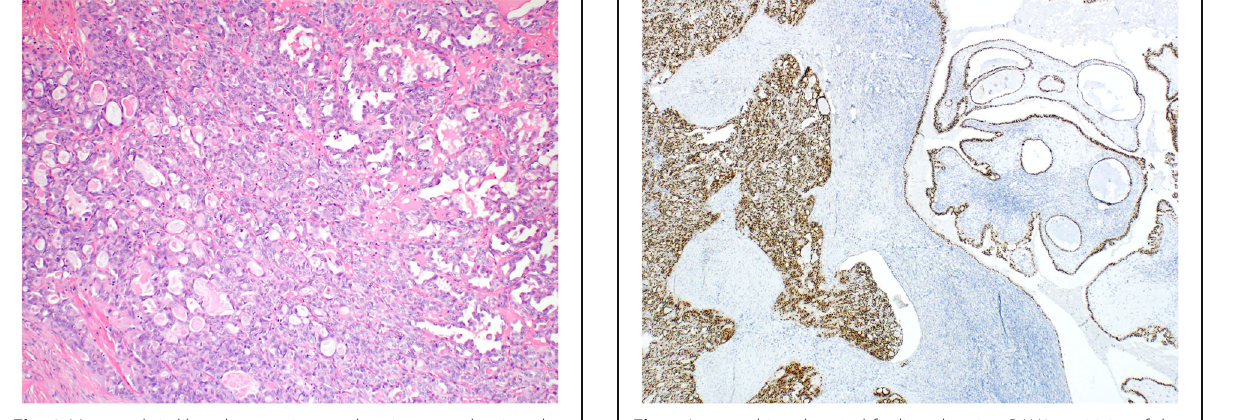
Fig. 4 Immunohistochemical finding showing PAX8 positivity of the tumor cells (40x). Note the positivity in both the serous borderline tumor (right) and mesonephric-like adenocarcinoma (left)